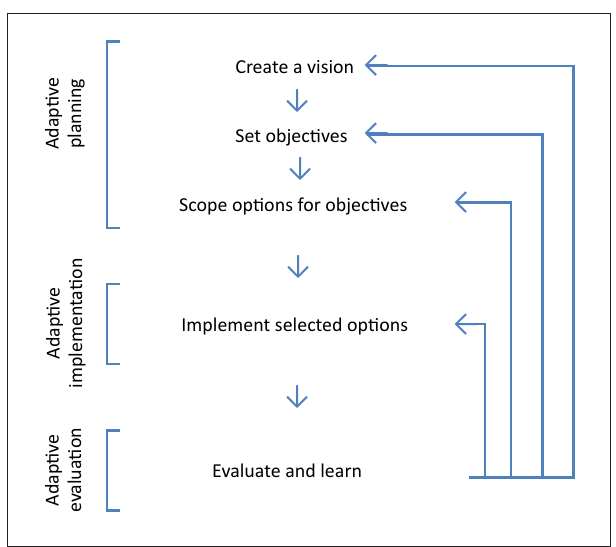
FIGURE 1: Schematic summary of the steps in the strategic adaptive management process, based on the work of Biggs, H.C. & Rogers, K.H., 2003, ‘An adaptive system to link science, monitoring and management in practice’, in J.T. du Toit, K.H. Rogers & H.C. Biggs (eds.), The Kruger experience. Ecology and management of savanna heterogeneity , pp. 59−80, Island Press, Washington DC; Pollard, S.R. & Du Toit, D.R., 2007, Guidelines for strategic adaptive management – Experiences from managing the rivers of the Kruger National Park. Guidelines of UNEP/GEF Project No. GF/27-13-03-4679. Ecosystems, Protected Areas and People Project; and Scholes, R.J. & Mennell, K.G., 2008, ‘Summary for policymakers’, in R.J. Scholes & K.G. Mennell (eds.),